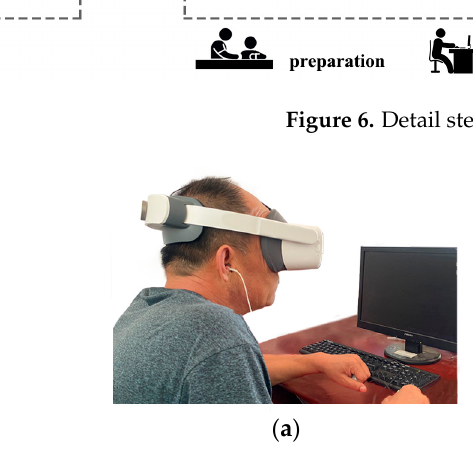
Figure 7. ( a ) The participant was shown virtual recovery scenarios at random for five minutes; ( b ) The participant finished the attention task. Photos were taken and used with permission.